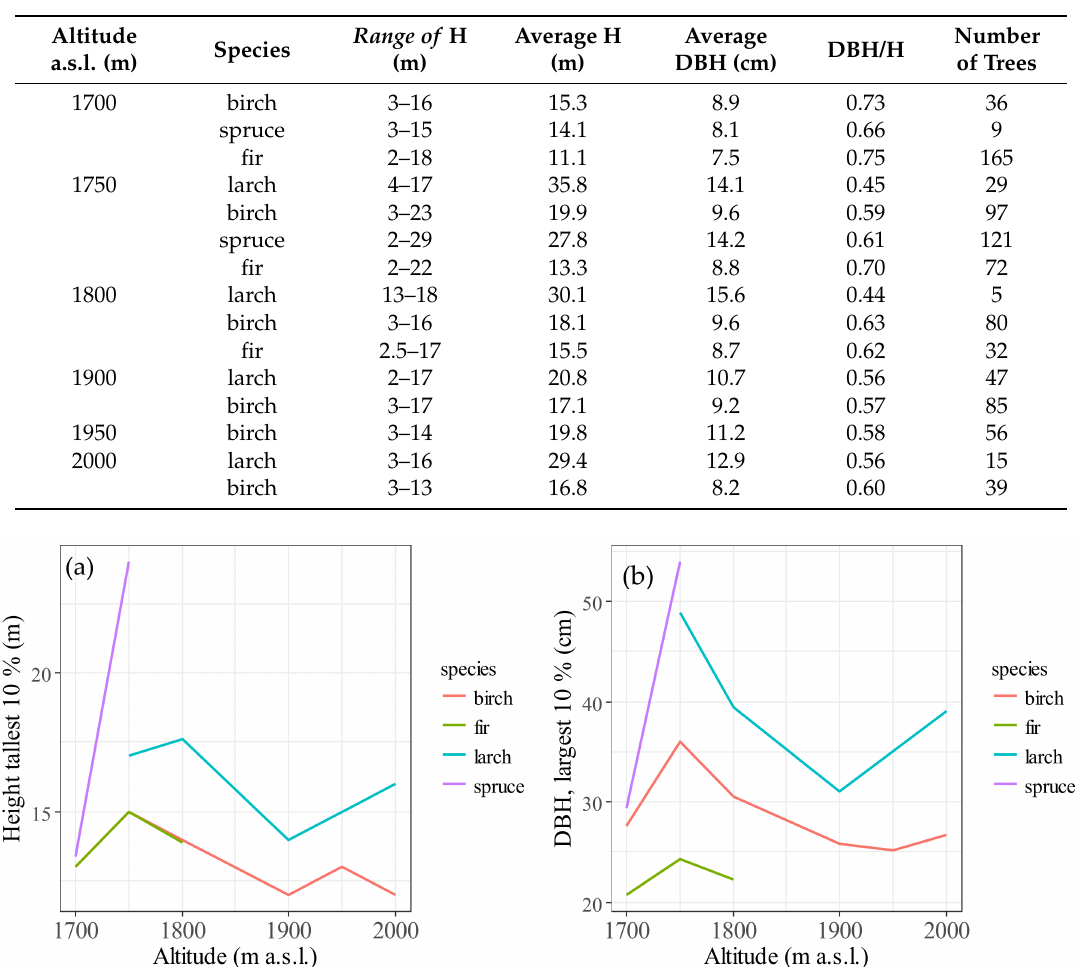
Table 3. Height and diameter of Erman’s birch ( Betula ermanii) , fir (Abies nephrolepis) , larch (Larix gmelinii) , and spruce (Picea jezoensis) in 18 plots along an altitudinal gradient on the north slope of Changbai Mountain. a.s.l.: Above see level.